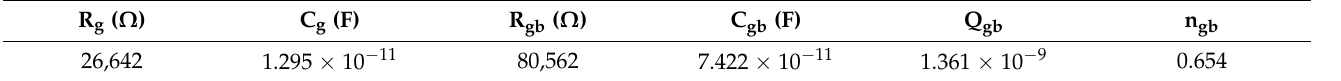
Figure 11. ( a , b ) Fitting of complex impedance Z (cid:48)(cid:48) vs. Z (cid:48) plot by >(R g C g ) (R gb Q gb ) and (R g C g ) (R gb Q gb C gb ) equivalent circuit models along with insets showing the residual plots. Table 2. Parameters extracted from ZView fitting of complex impedance